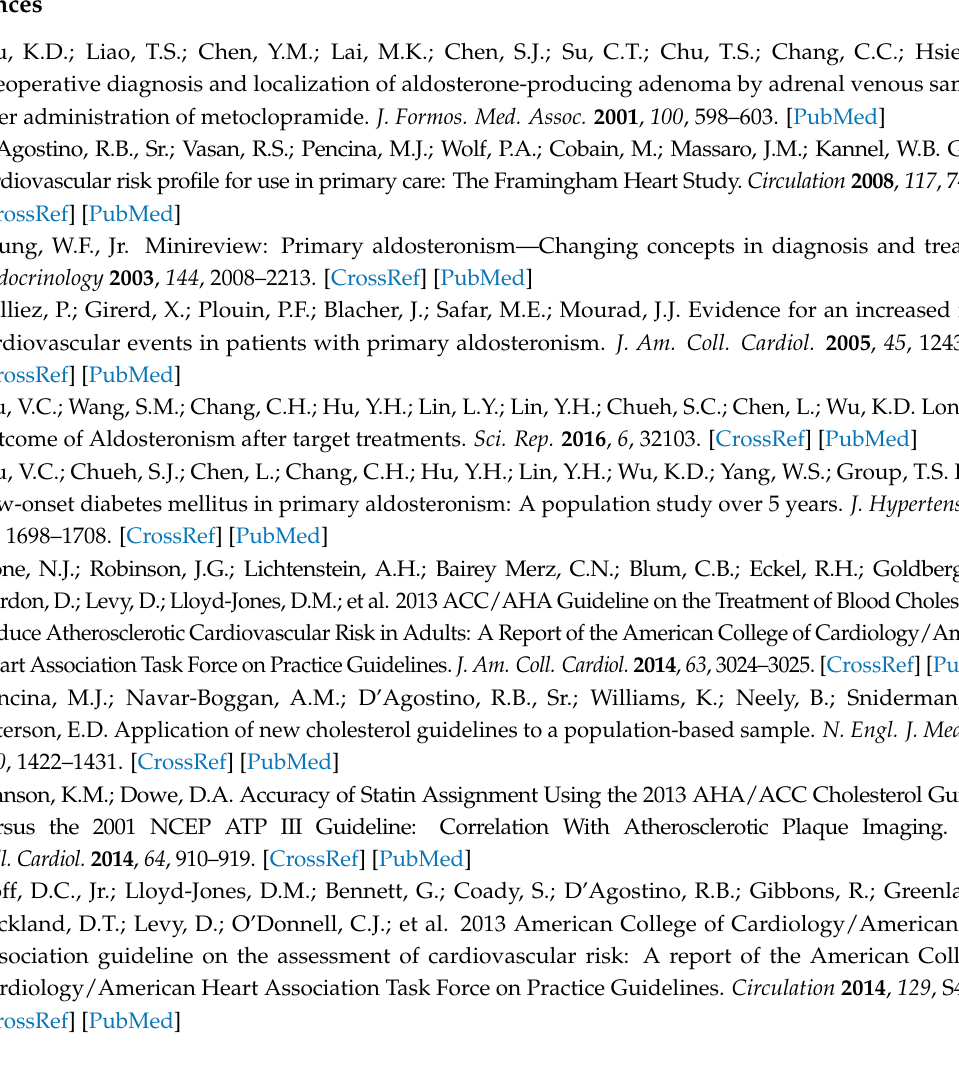
/11/382/s1. Figure S1: Major recommendations for statin therapy on 10-year ASCVD prevention under ACC-AHA guideline recommendations. Table S1. The sensitivity and specificity for 10-year ASCVD in middle-aged hypertensive patients with PA and EH by the recommendation of statin use based on ACC-AHA guideline. Table S2. Demographic comparisons of enrollees between PAC < 60 ng/dL and PAC ≥ 60 ng/dL. Author Contributions: Y.-F.L. (Yu-Feng Lin) and J.-H.L.: draft writing; J.-H.L., Y.-F.L. (Yu-Feng Lin), and V.-C.W.: data acquisition and statistical analysis; Y.-F.L. (Yu-Feng Lin) and J.-H.L.: drafting of the manuscript; Y.-F.L. (Yuh-Feng Lin), W.-J.W., S.-C.J.C., V.-C.W., T.-S.C., and K.-D.W.: study concept and design;